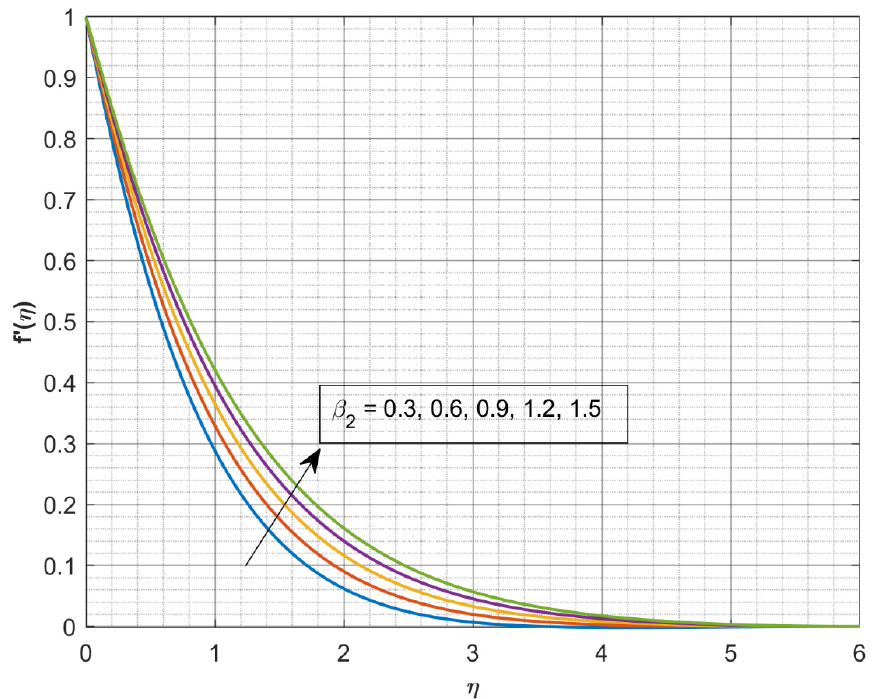
Figure 4. Influence of 𝛽 (cid:2870) on 𝑓 ′ ( 𝜂 ) .